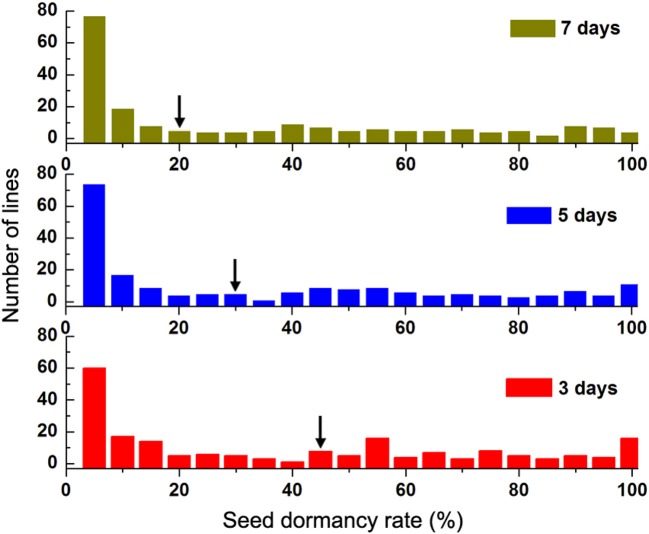
Frequency distributions of seed dormancy rate (Dor) of the advanced backcross population on the day 3, 5, and 7. Red: seed dormancy rate on the day 3; Blue: seed dormancy rate on the day 5; Green: seed dormancy rate on the day 7. Black arrows indicate the mean values of Dor from Zhoumai 18.